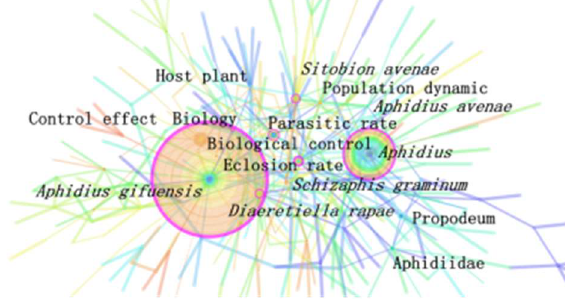
Figure 2. The keywords of aphids parasitoids research in